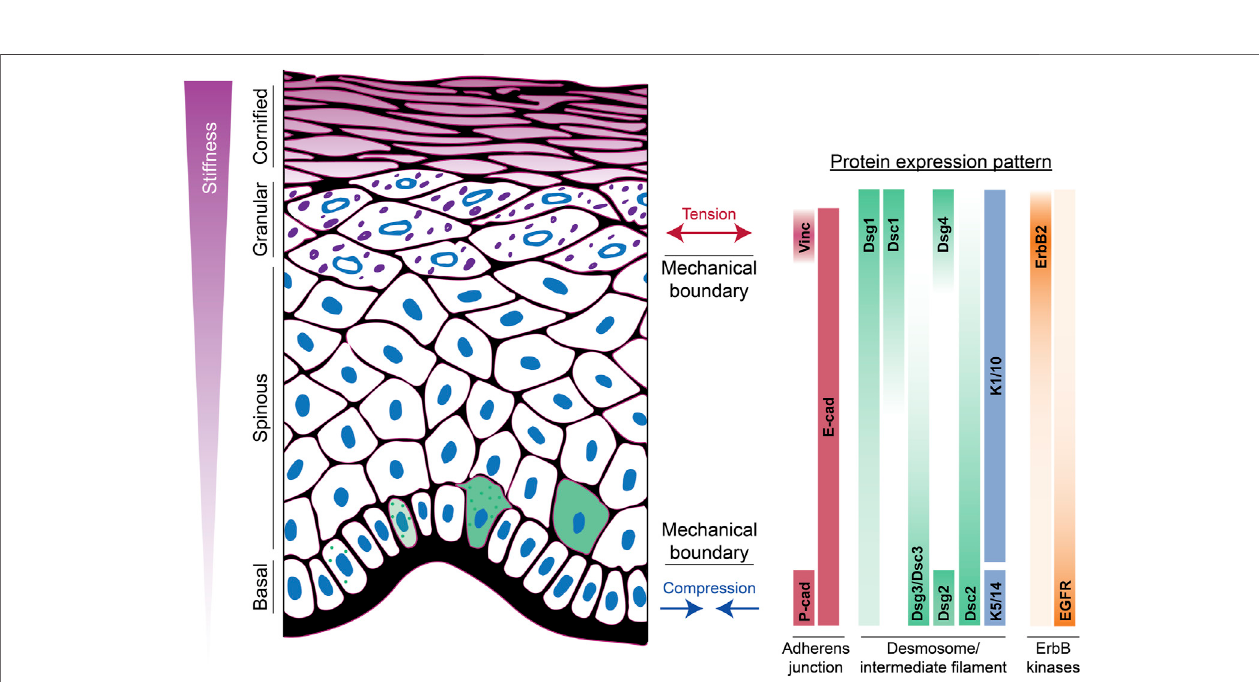
FIGURE 2 | Apicobasolateral polarization of junctions and the cytoskeleton in the epidermis. The spatial distribution of adherens junction, desmosomal, and ErbB tyrosinekinasefamily proteinsacrossthedifferentlayersoftheepidermisisshown.Thispatternedexpressionisassociatedwithdevelopmentofmechanicalboundaries in both the upper and lower layers. In the basal layer, cells experience compressive forces, while suprabasal layers experience tension. Moreover, there is a stiffness gradientrangingfromleaststiffinbasalcellstomoststiffincorni fi edcells.GreencellsindicateonsetofDsg1expression,inductionofdifferentiation,andmovement into the suprabasal layer. Vinc, vinculin; cad, cadherin; Dsc, desmocollin; Dsg, desmoglein; K, keratin.